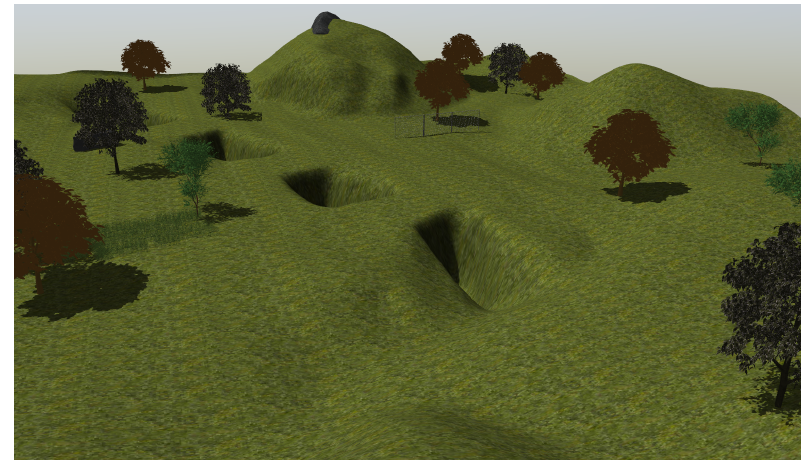
Figure 20. Modeled natural scenario for simulated testing [25].